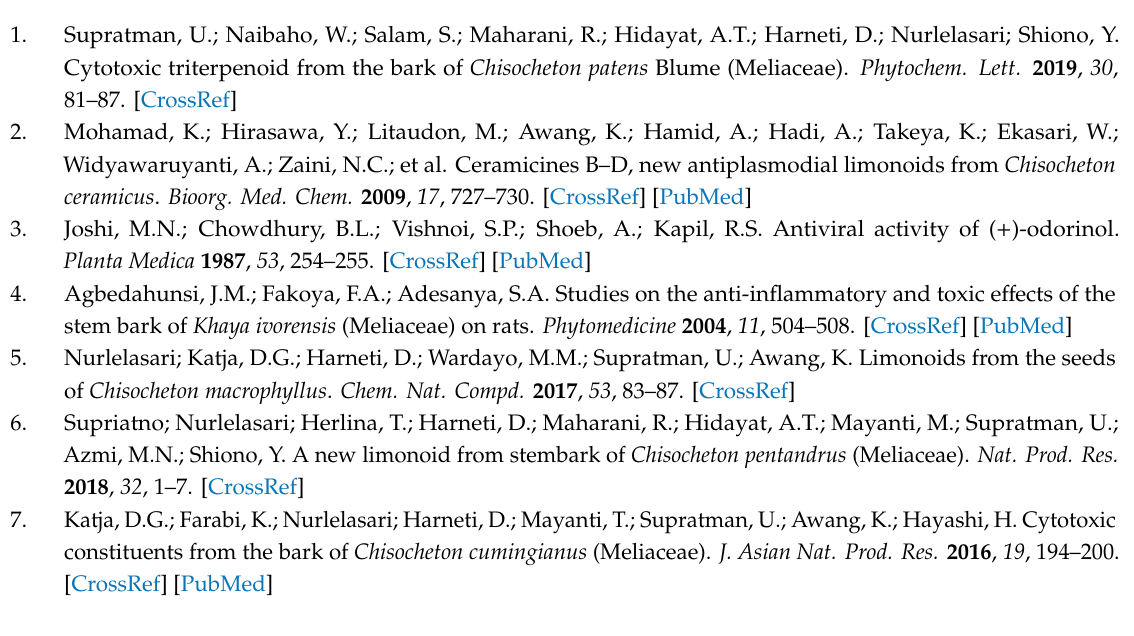
Figure S4: HSQC Spectrum of 1 , Figure S5: HMBC Spectrum of 1 , Figure S6: 1 H- 1 H-COSY Spectrum of 1 , Figure S7: NOE-1D Spectrum of 1 (500 MHz in CDCl 3 ), Figure S8: HRESI-TOF-MS Spectrum of 1 , Figure S9: TLC profile of 1